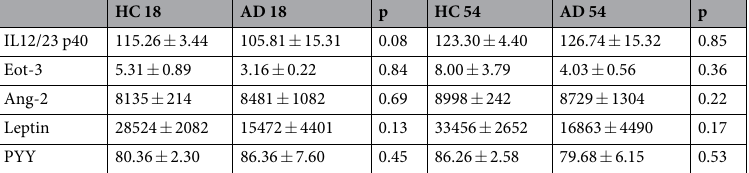
Table 5. General Linear Model analysis of 5 biomarkers in HC and AD at 18 and 54 month time points in APOE ε 4 − in non-converters only. Data are presented as Mean ± S.E., although statistical analysis was performed on the log 10 value to better approximate a normal distribution.